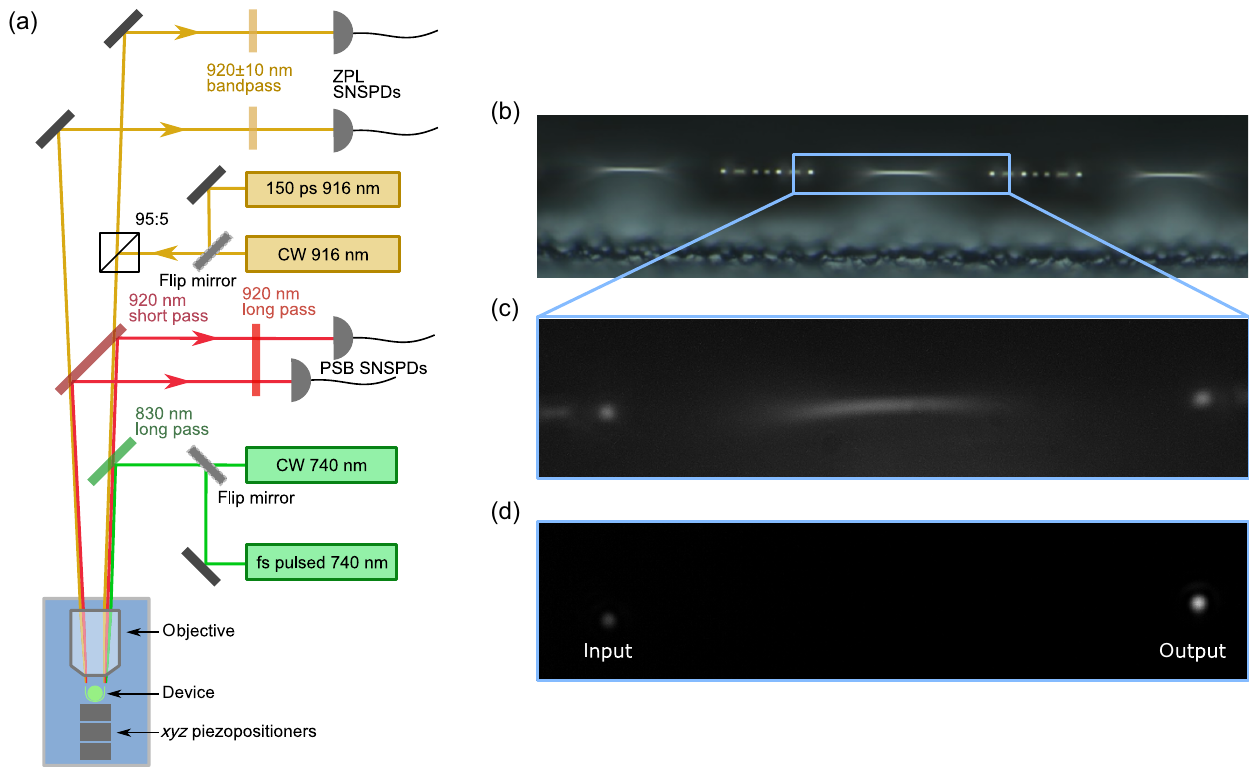
FIG. 7. Experimental setup. (a) Diagram of optical paths, laser sources, and detectors. (b) Optical microscope image of a row of disk resonators (three resonators are visible), taken using a commercial optical microscope. (c) Optical image of a single device under illumination as seen through the cryostat objective. (d) Optical image of the device without illumination and laser light coupling into the left waveguide facet, passing through the waveguide and emitting from the right waveguide facet.